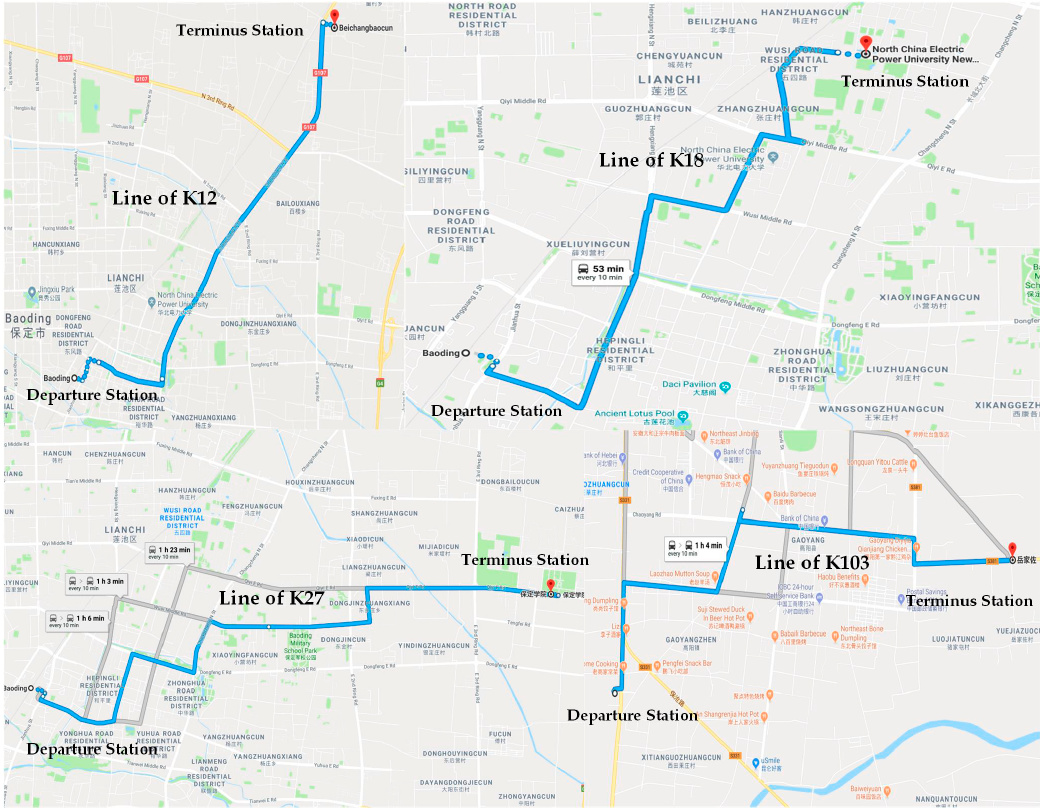
Figure 6. Investigation of road route map of bus line.